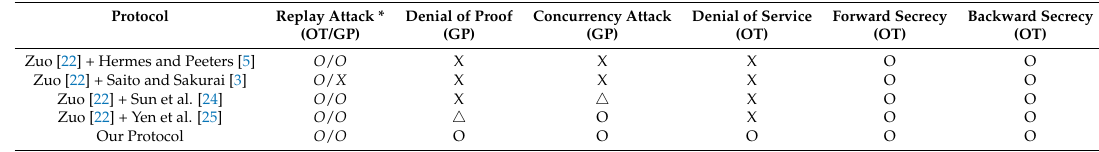
Table 2. Comparison of security features of different